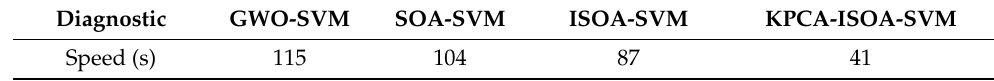
Table 7. Fault model diagnosis